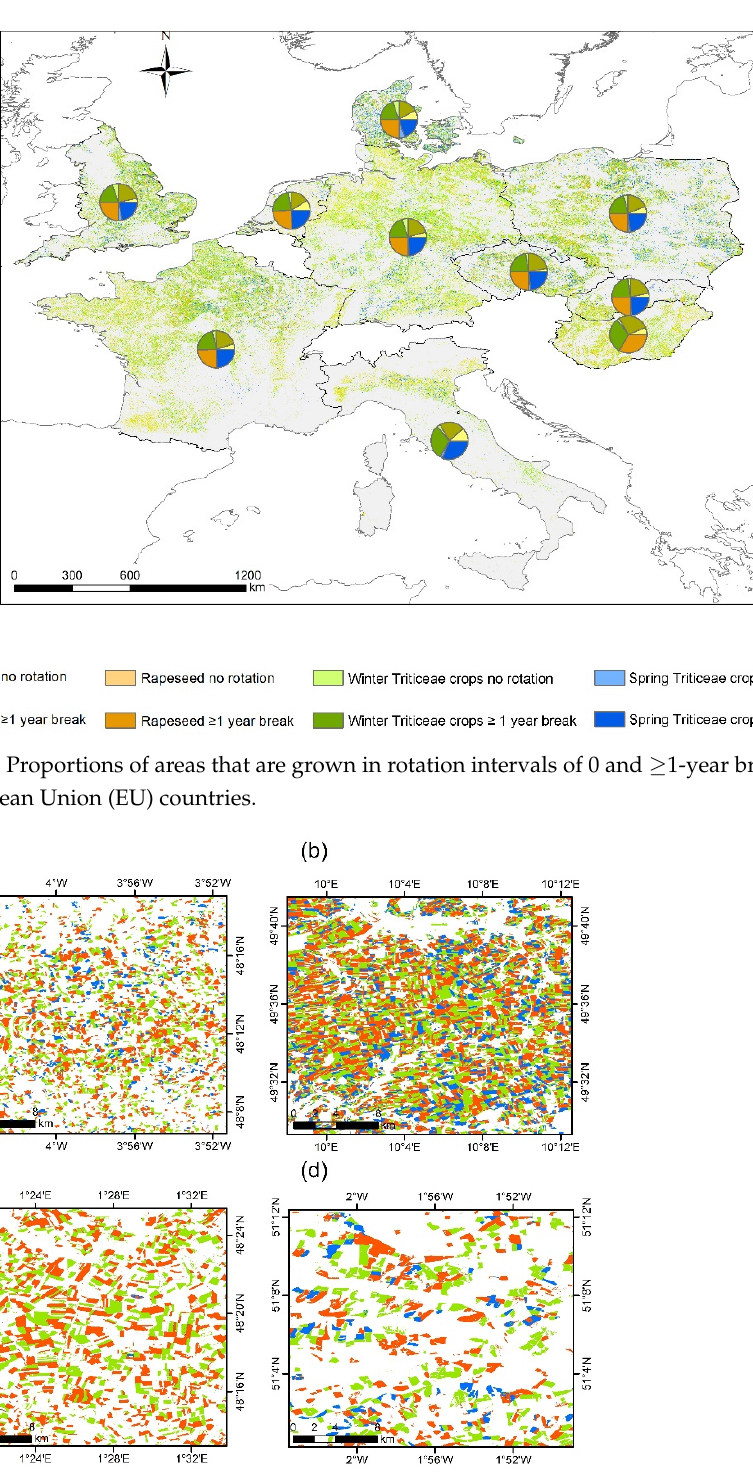
Figure 10. Area proportions of ( a ) winter Triticeae crops, ( b ) maize, ( c ) rapeseed, and ( d ) spring Triticeae crops, converted to other land cover types.